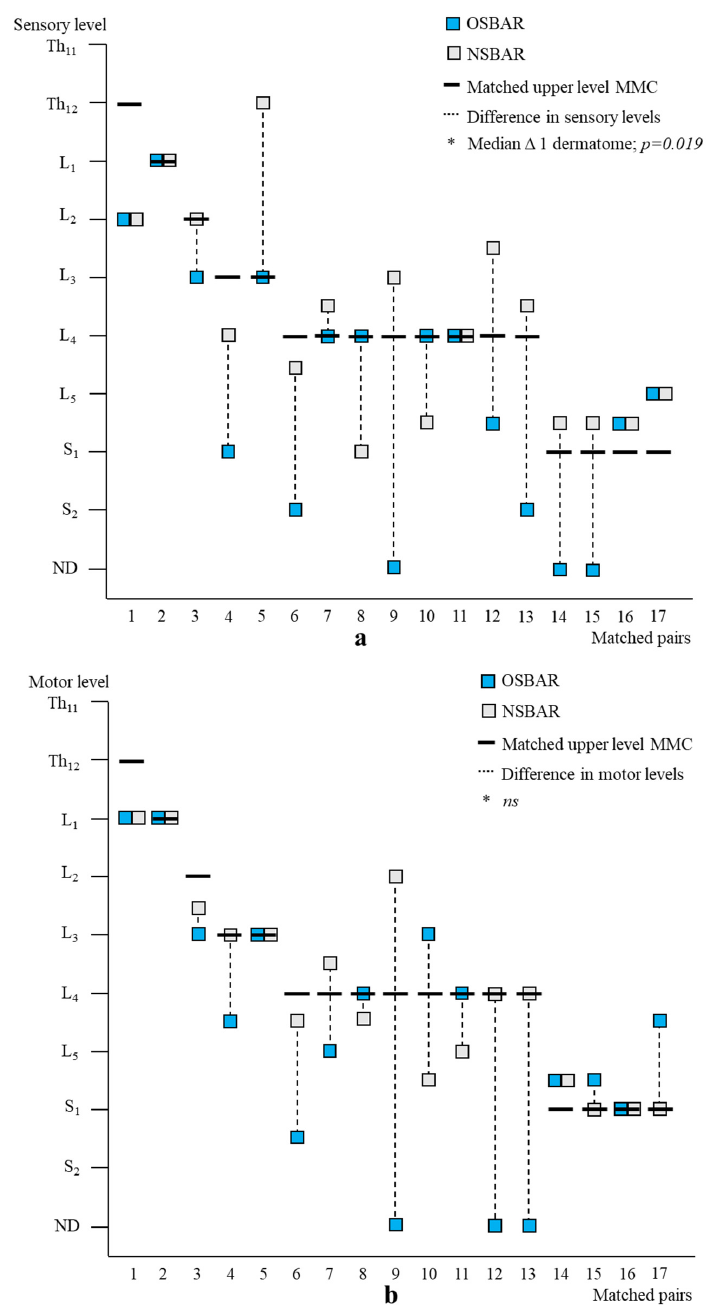
Figure 4. Segmental neurologic outcome comparison between OSBAR and NSBAR. ( a ): Segmental sensory function of age- and lesion-matched pairs after OSBAR and NSBAR interventions. The x -axis indicates the matched pairs. The y -axis indicates the segmental sensory function. Sensory function was better preserved in OSBAR than in NSBAR. * Median difference 1 dermatome; p = 0.019. ( b ): Segmental motor function of age- and lesion-matched pairs after OSBAR and NSBAR interventions. The x -axis indicates the matched pairs. The y -axis indicates the segmental motor function. The motor function did not significantly differ between OSBAR and NSBAR; ns = not significant. Abbreviations: ND = no deficit. MMC = myelomeningocele; OSBAR = fetal intervention technique by the open approach; NSBAR = neonatal MMC